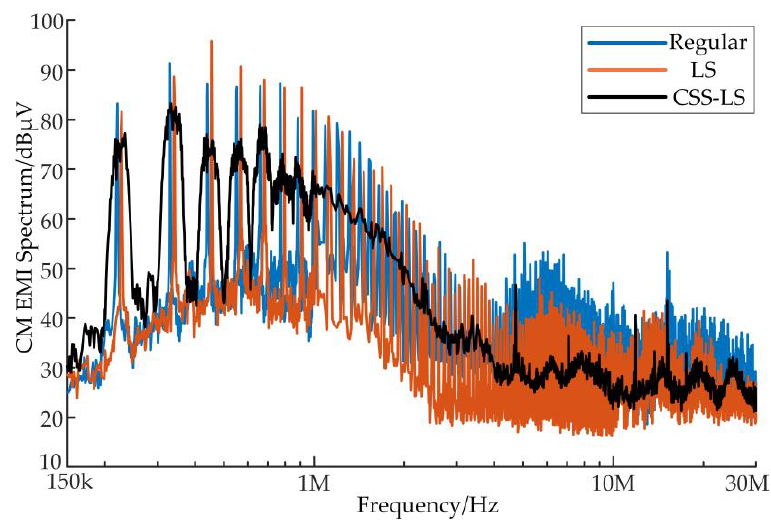
Figure 12. Chaotic spread spectrum: ( a ) Chaotic attractor and ( b ) Sawtooth waveform.